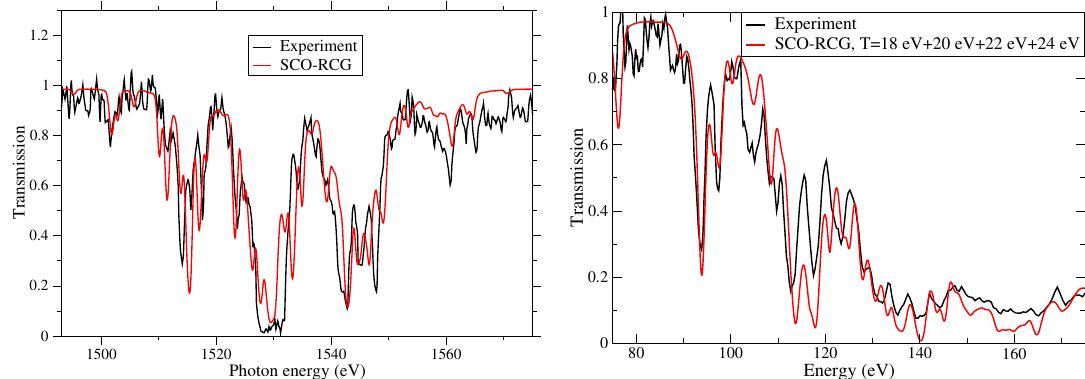
Figure 1. Left : aluminum transmission spectrum measured by Davidson et al. [27] on HELEN laser facility in the United Kingdom and interpreted by SCO-RCG at T = 37 eV and ρ = 0.01 g/cm 3 . The areal mass is equal to 54 µ g/cm 2 . Right : aluminum spectrum measured by Winhart et al. [28,29] on ASTERIX IV laser facility in Germany and interpreted by SCO-RCG at ρ = 0.01 g/cm 3 and averaged over four temperatures ( T = 18, 20, 22 and 24 eV) in order to simulate the gradients. The areal mass is equal to 30 µ g/cm 2